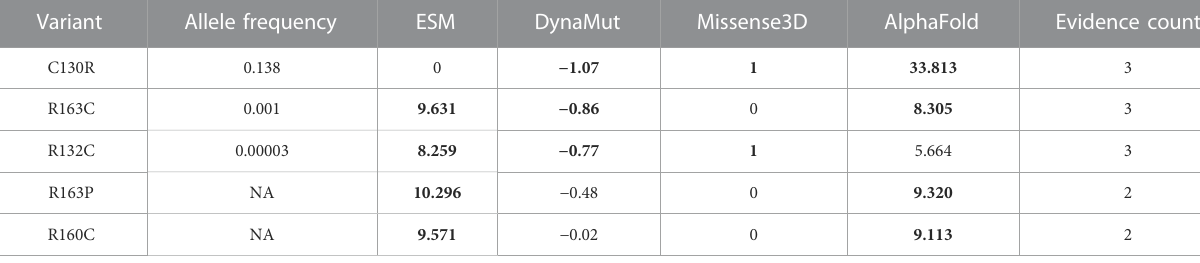
TABLE 1 Five candidate variants that affect APOE